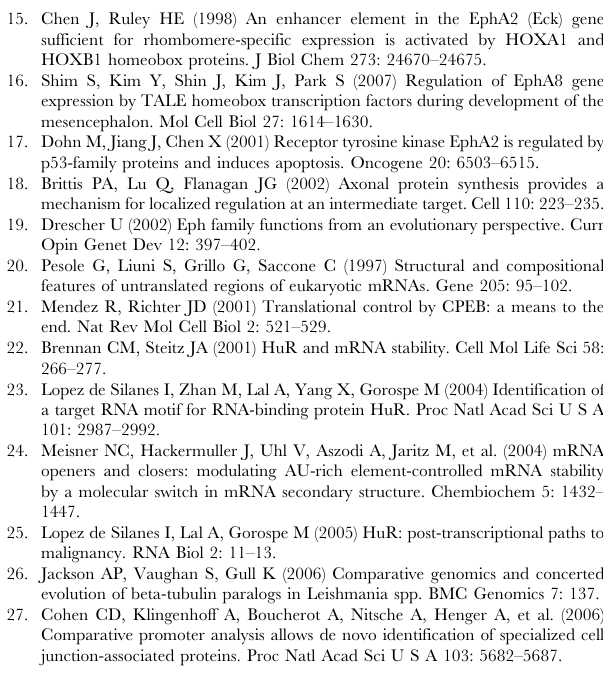
Table S3 Primers used for Real Time RT-PCR